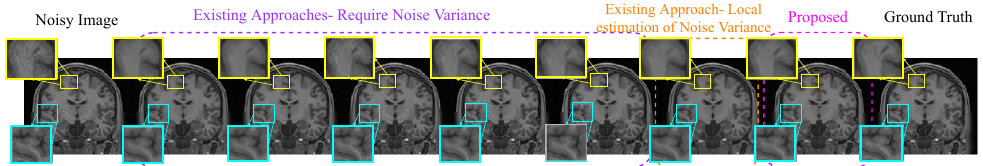
Figure 6. Demonstration of image denoising achieved by different denoising algorithms on real MR images with synthetically added 2% Gaussian noise. From left to right—noisy image, optimized blockwise non local means (ONLM) [57], multi-resolution based ONLM (MRONLM) [41], oracle based discrete cosine transform (ODCT), PCA-based denoising over ODCT (PRINLM) [35], variance stabilized transform with blockwise matching and 4D filtering (VST-BM4D) [25], adaptive ONLM (AONLM) [40], the proposed approach, and the original noiseless